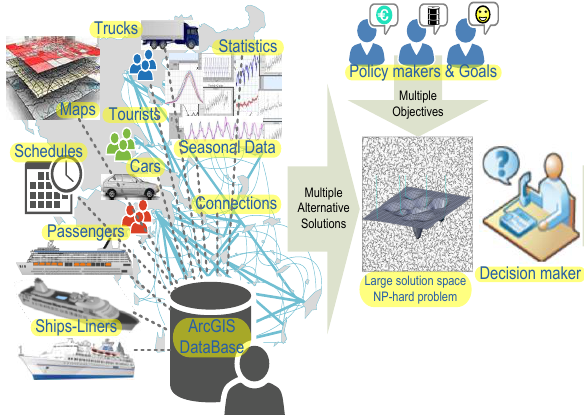
Figure 1. Schematic of the Decision Support for the Coastal Network Designer by the Optimization tool in